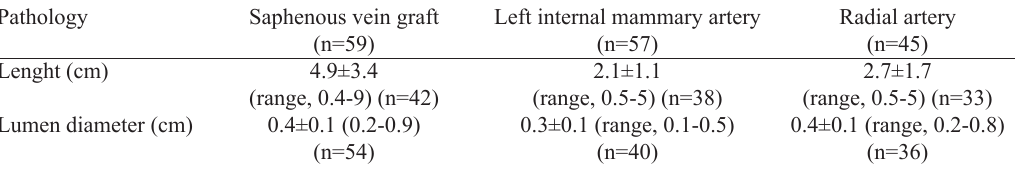
Table 3. Measurements of the inspected remnants of the